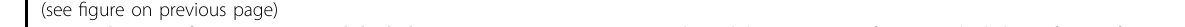
Fig. 3 Silencing of MEG3 attenuated the kidney injury in vivo. A RT-qPCR indicated the expression of MEG3 in the kidney of mice after injection of AAV-sh-MEG3 vector. B H&E staining exhibited the effects of downregulation of MEG3 on tubular injury. Red arrow indicates coagulative necrosis with tubular structures; black arrow indicates renal tubule vacuole; blue arrow indicates renal tubular necrosis and detachment. C , D A TUNEL assay was applied to detect the number of TUNEL-positive cells. E In fl uence of silenced MEG3 on caspase 3 activity. F , G The effects of silenced MEG3 on the levels of BUN and creatinine in the serum were measured. H The effects of silenced MEG3 on tubular injury index were determined. I An mt- Keima assay was used to detect the mitophagy activity following IRI and under the in fl uence of MEG3 de fi ciency. J , K Western blot analysis of Parkin, p62, LC3B-I, and LC3B-II levels in kidney tissues from IRI mice and sham mice. ** p <